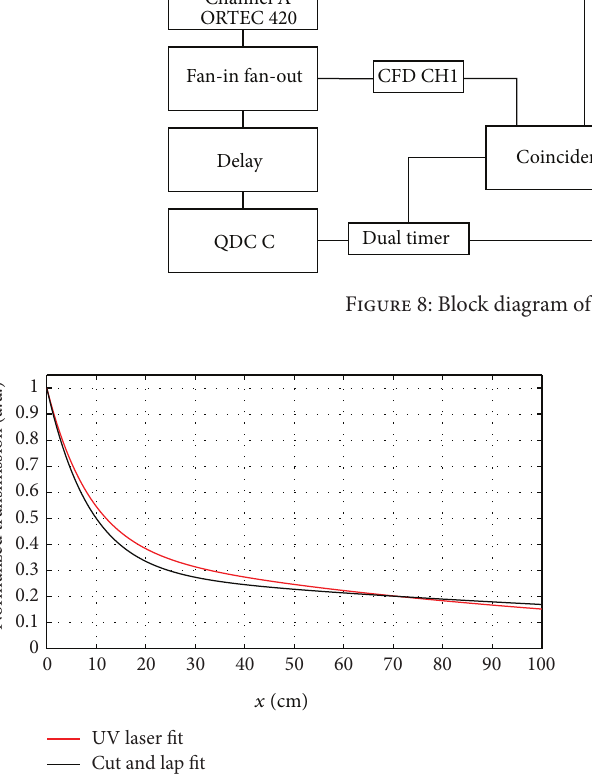
Figure 9: Plot of the two normalized attenuation length functions. In blue, the attenuation length for the cut and lap quality control, with coaxial light injection. In red, the attenuation length function obtained by UV laser.